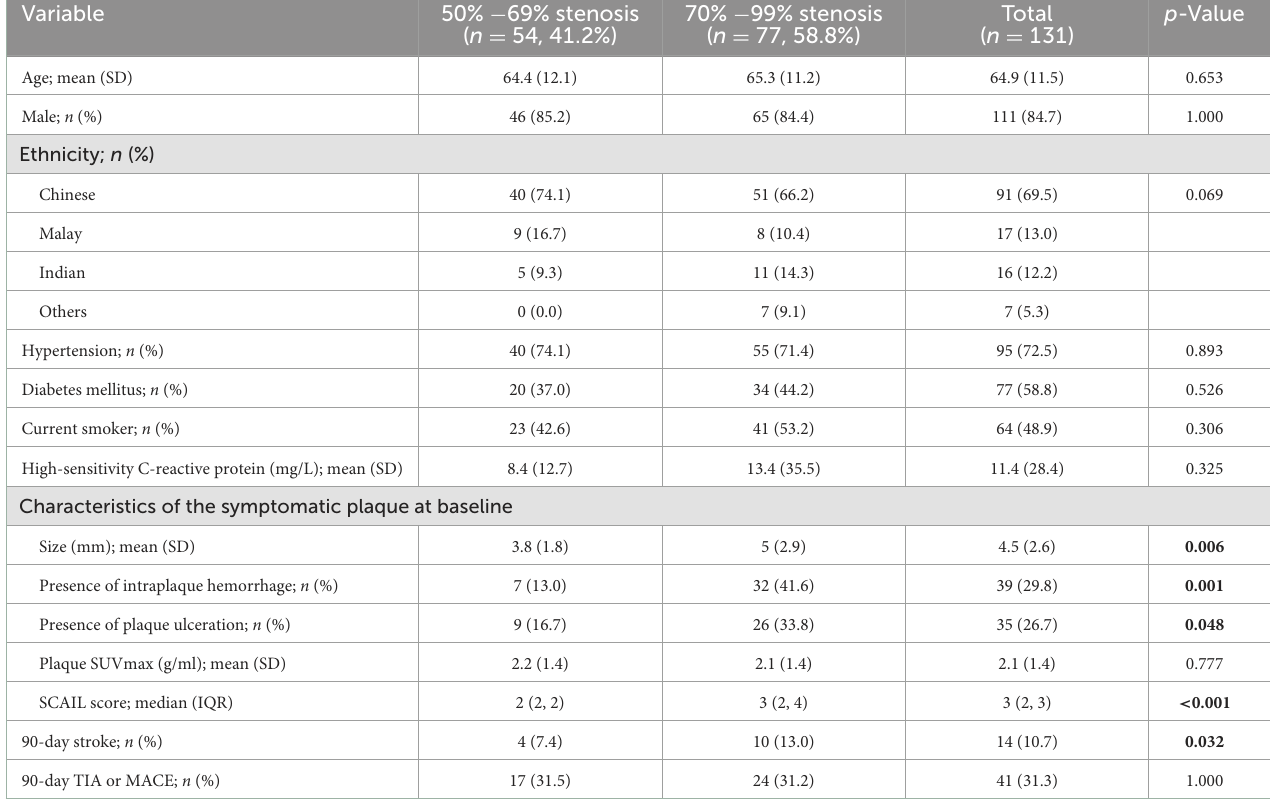
TABLE 1 Baseline characteristics of the study population stratified by the degree of stenosis in the symptomatic carotid artery.